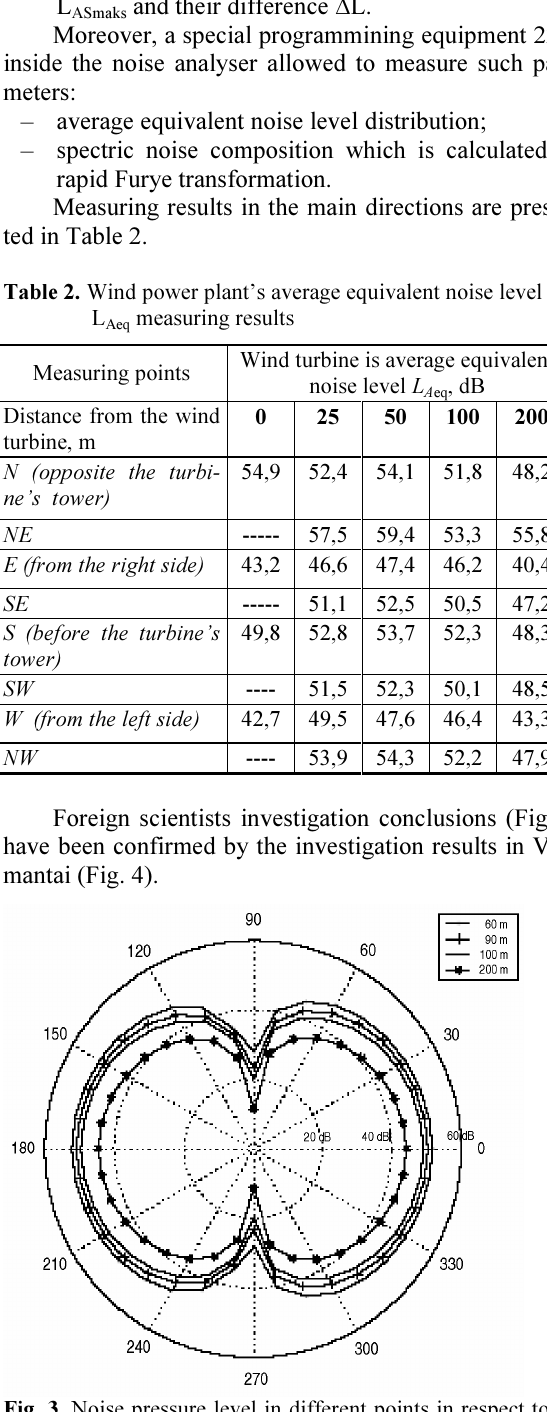
Table 1. Short characteristics of the investigated wind turbine